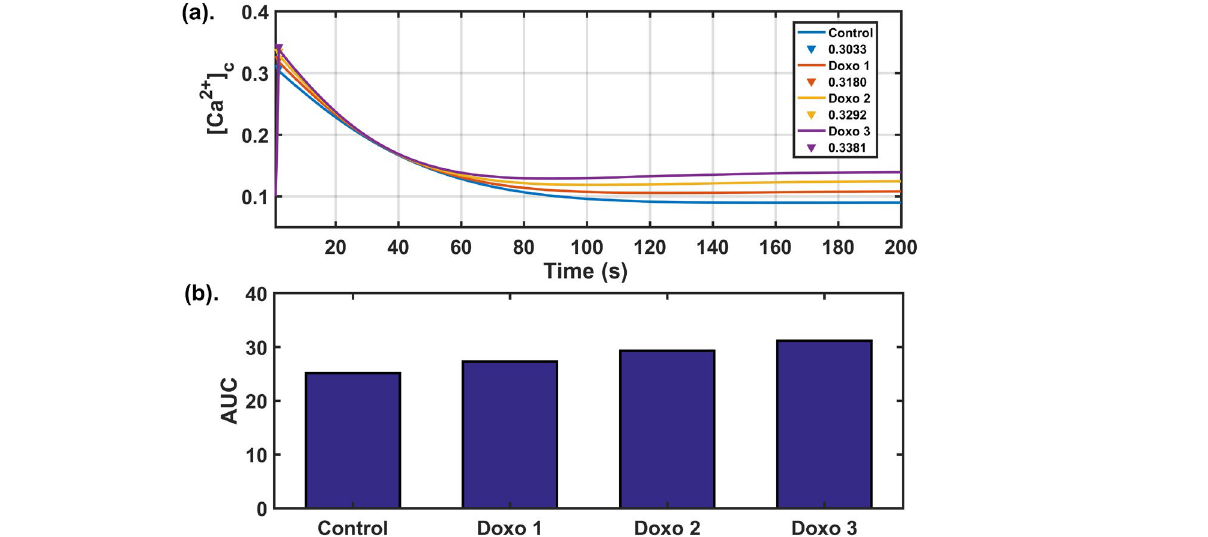
Explor Target Antitumor Ther. 2021;2:208-26 | https://doi.org/10.37349/etat.2021.00042